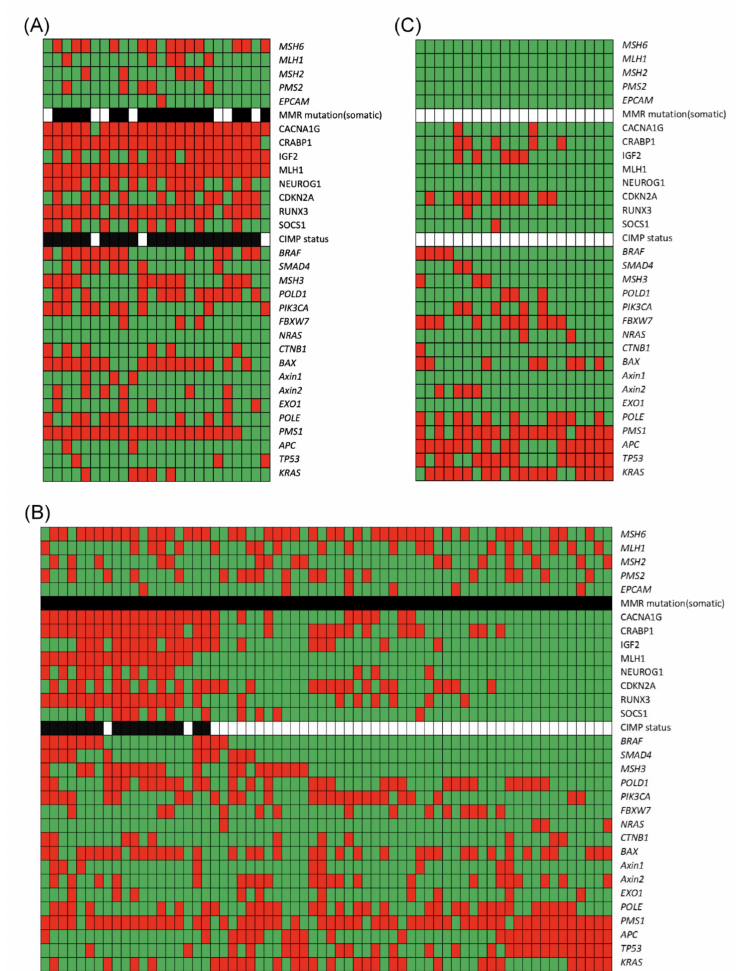
Figure 2. The mutational profiles in MSI-high CRC according to the cause of MSI-high. ( A ) MSI-high CRC with MLH1 methylation, ( B ) MSI-high CRC with MMR mutation, ( C ) MSI-high CRC with no obvious cause for MSI-high. Green field: genetic mutation ( − ); red field: genetic mutation ( + ); white field: no MMR mutation or CIMP − ; black field: MMR mutation or CIMP +